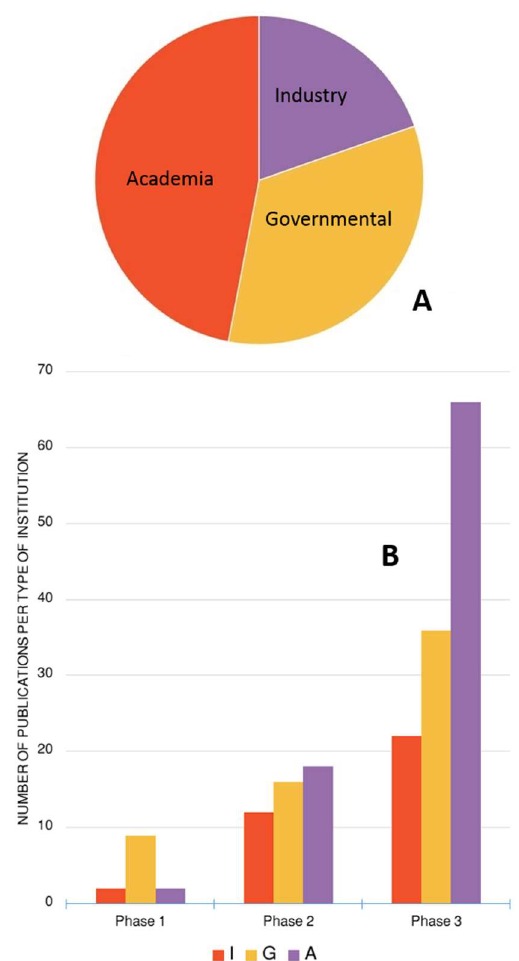
Figure 10. Qualitative and quantitative results of the institutional arrangements parameters. ( A ). Type of institution of the first author in each peer-reviewed publications between 1982 and 2016. ( B ). Number of each type of institution over the 35-year period analyzed.